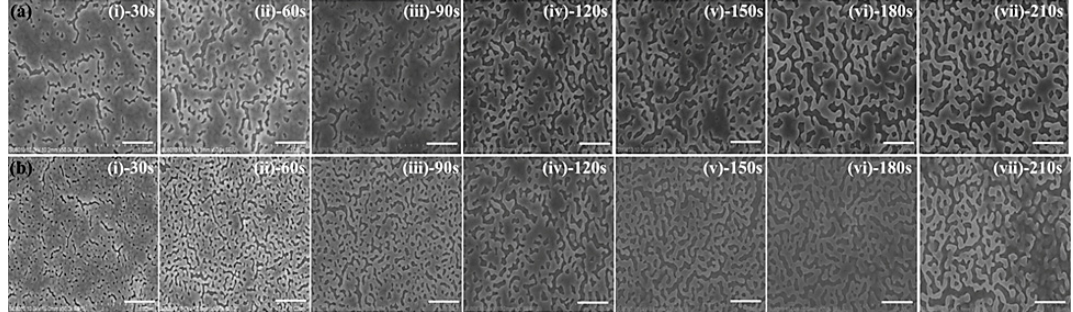
Figure 2. Field-emission scanning electron microscopy (FE-SEM) top-view images of as-fabricated plasmonic Au nanoporous substrates fabricated using deposition rates of ( a ) 0.3 Å/s and ( b ) 1 Å/s, and various dealloying durations (scale bar: 500 nm) were present.